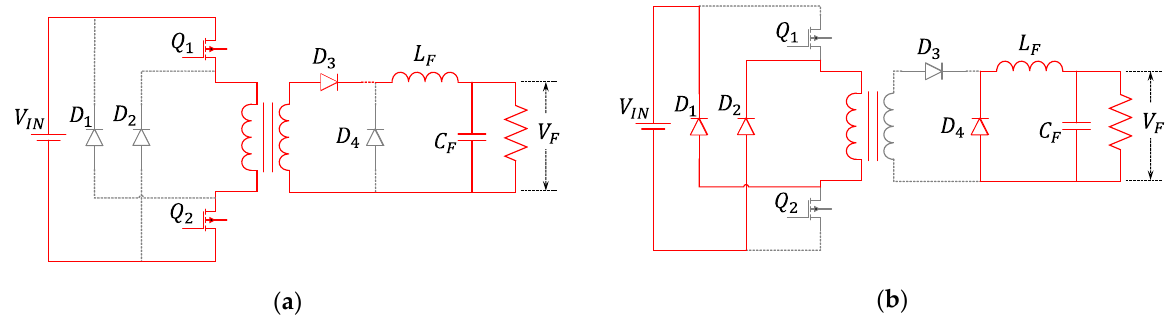
Figure 4. The equivalent circuits of the two ‐ switch forward converter: ( a ) ON state; ( b ) OFF state.